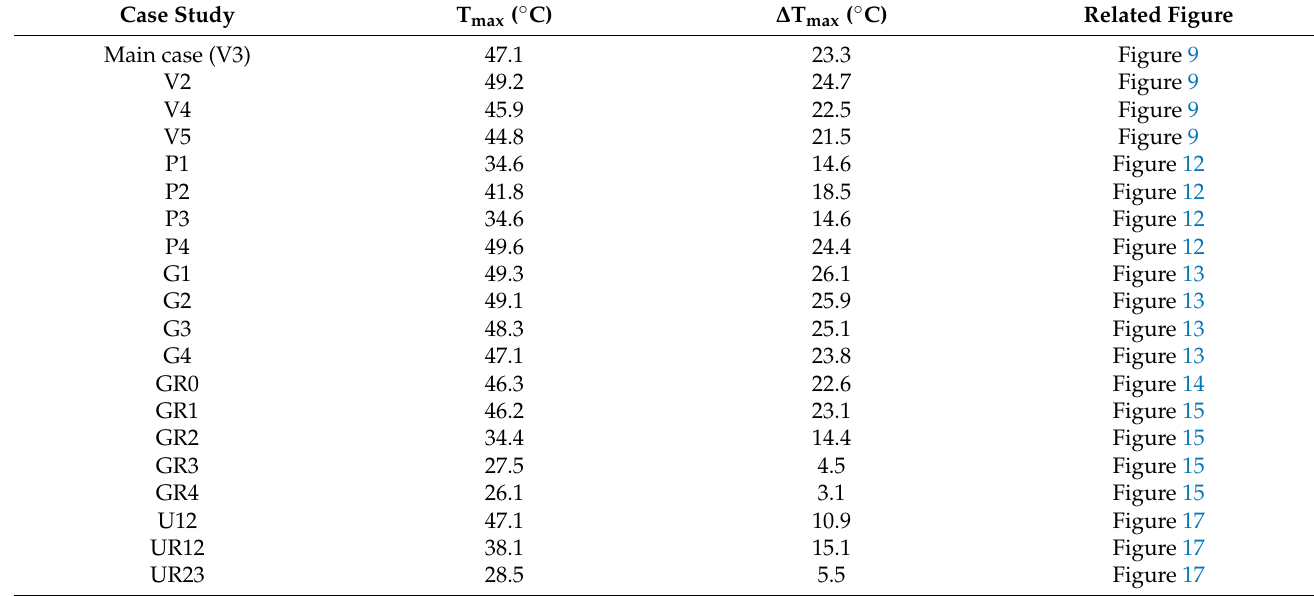
Table 4. Comparison of the optimization studies with the main case